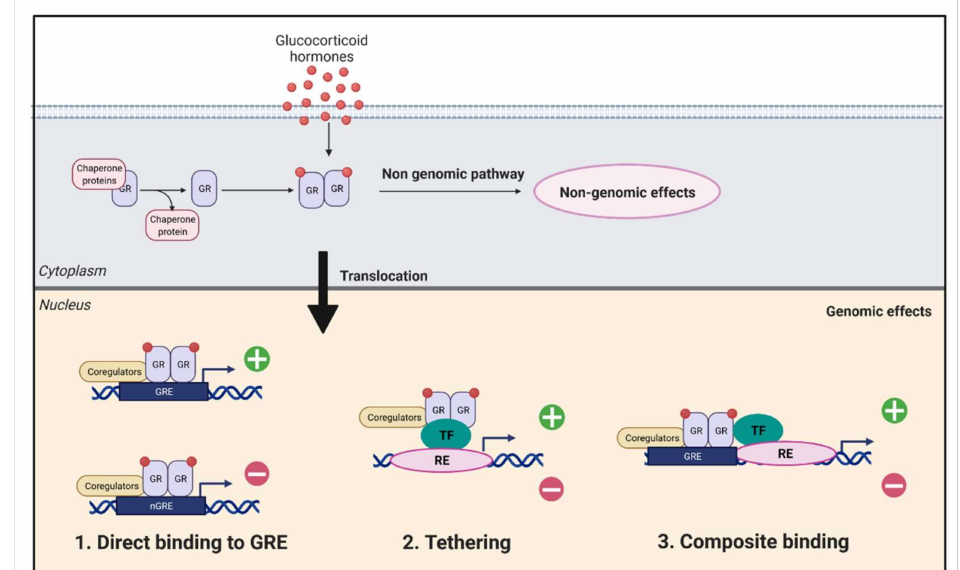
Figure 2. Mechanisms of glucocorticoids activity. Glucocorticoids will penetrate the plasma mem- brane to the cytoplasm, where they will have genomic and non-genomic effects. Following the binding of the hormone on its receptor (GR), the complex will be translocated into the nucleus and will have multiple mechanisms. ( 1 ) The binding of the complex on the response element of glucocorticoids (GRE), which will allow the expression or repression of target genes. ( 2 ) The complex binds to a transcription factor (TF) located on its response element (RE) in order to prevent or activate transcription. ( 3 ) Binding of the complex to DNA and protein substrates to prevent or activate transcription (created with